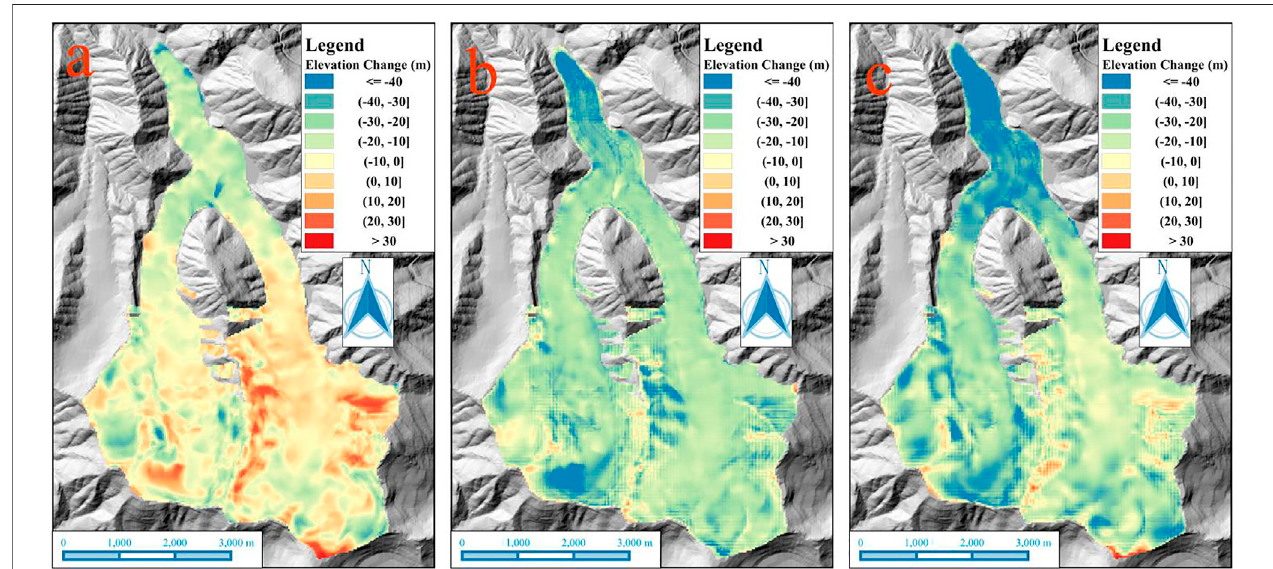
FIGURE 4 | Changes in surface elevation of the LHG12. (A) During 1957 – 1989. (B) During 1989 – 5015. (C) During 1957 – 2015.